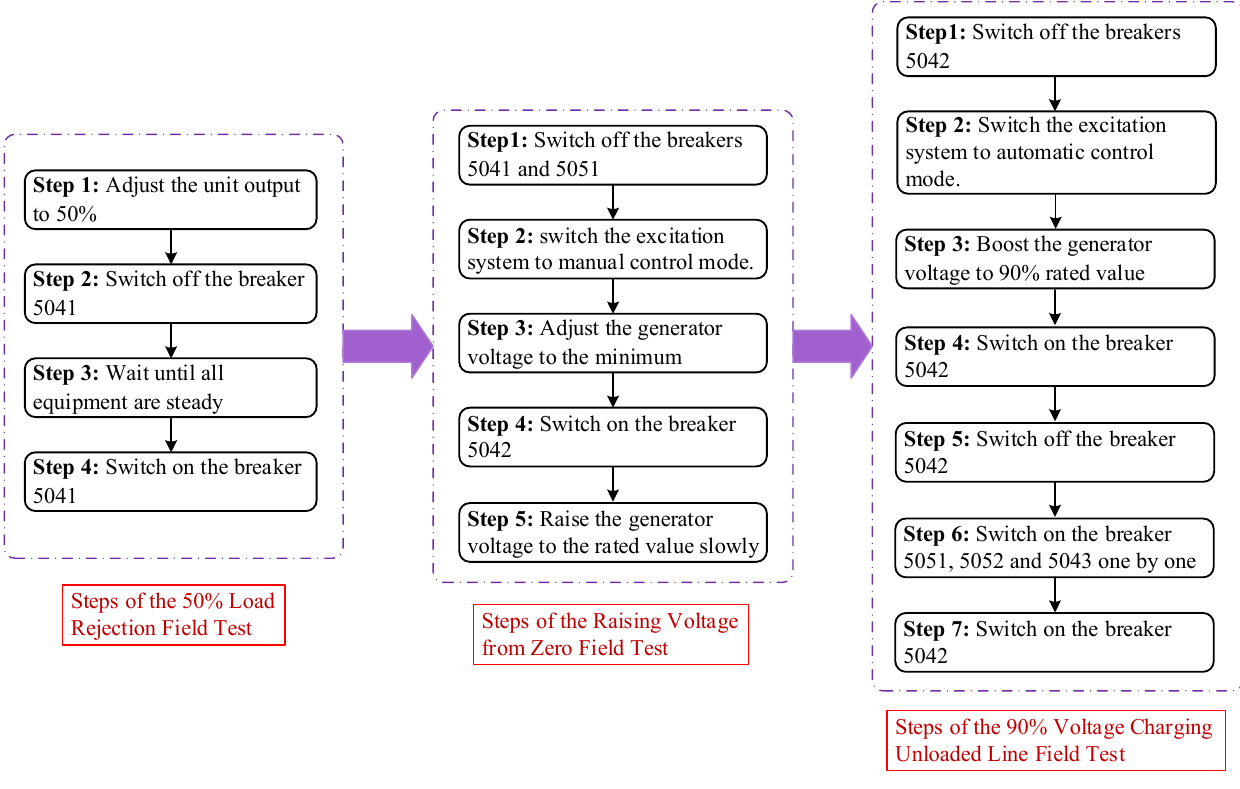
Figure 13. Steps of the field